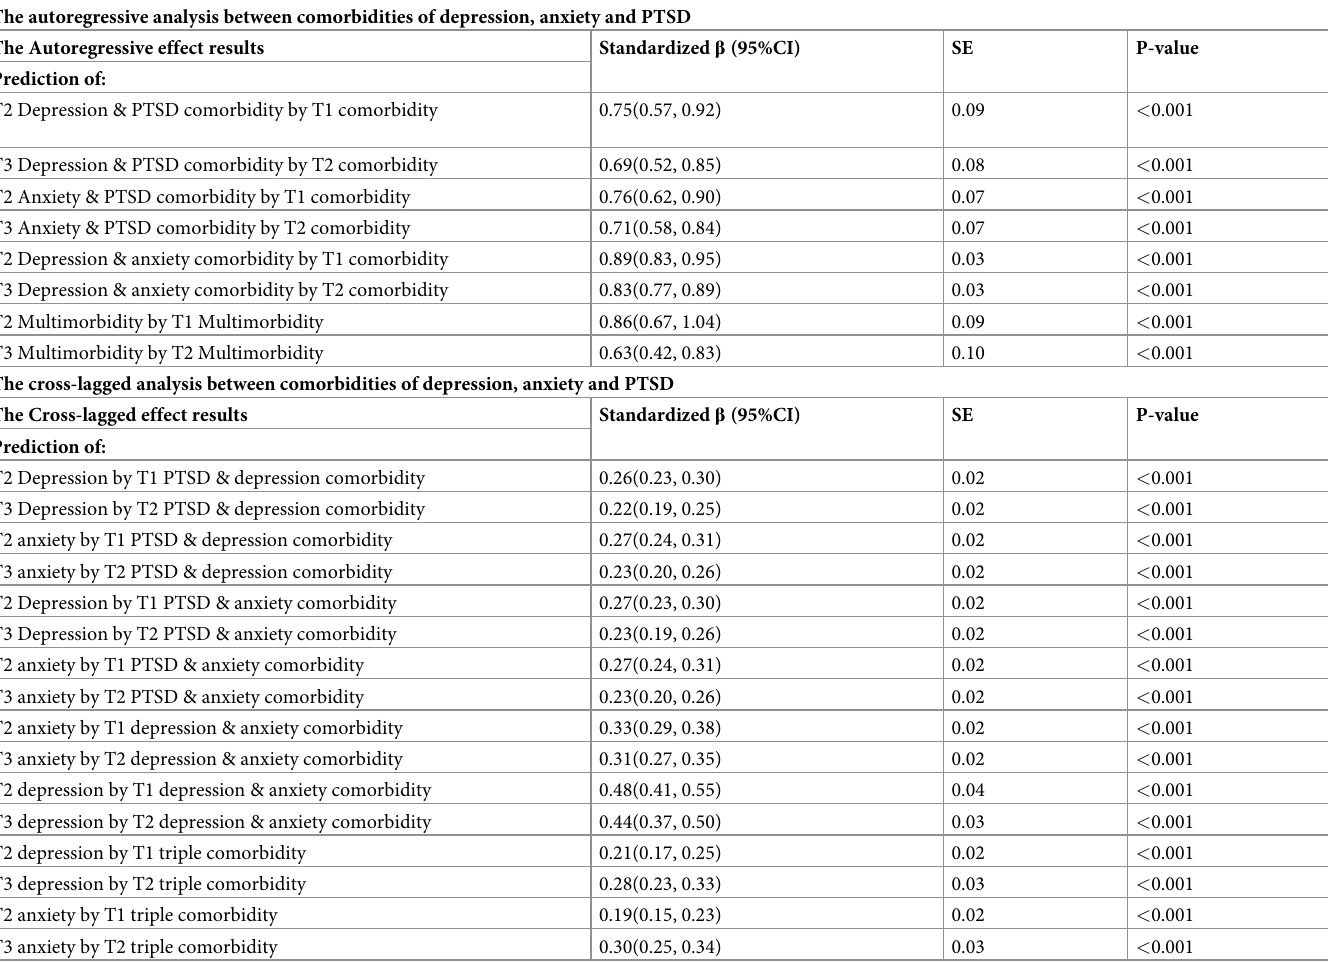
Table 4. Results of a cross-lagged autoregressive analysis for the association of depression, anxiety and PTSD with their comorbidities, among postpartum women in Northwest Ethiopia, 2021. The autoregressive analysis between comorbidities of depression, anxiety and PTSD The Autoregressive effect results